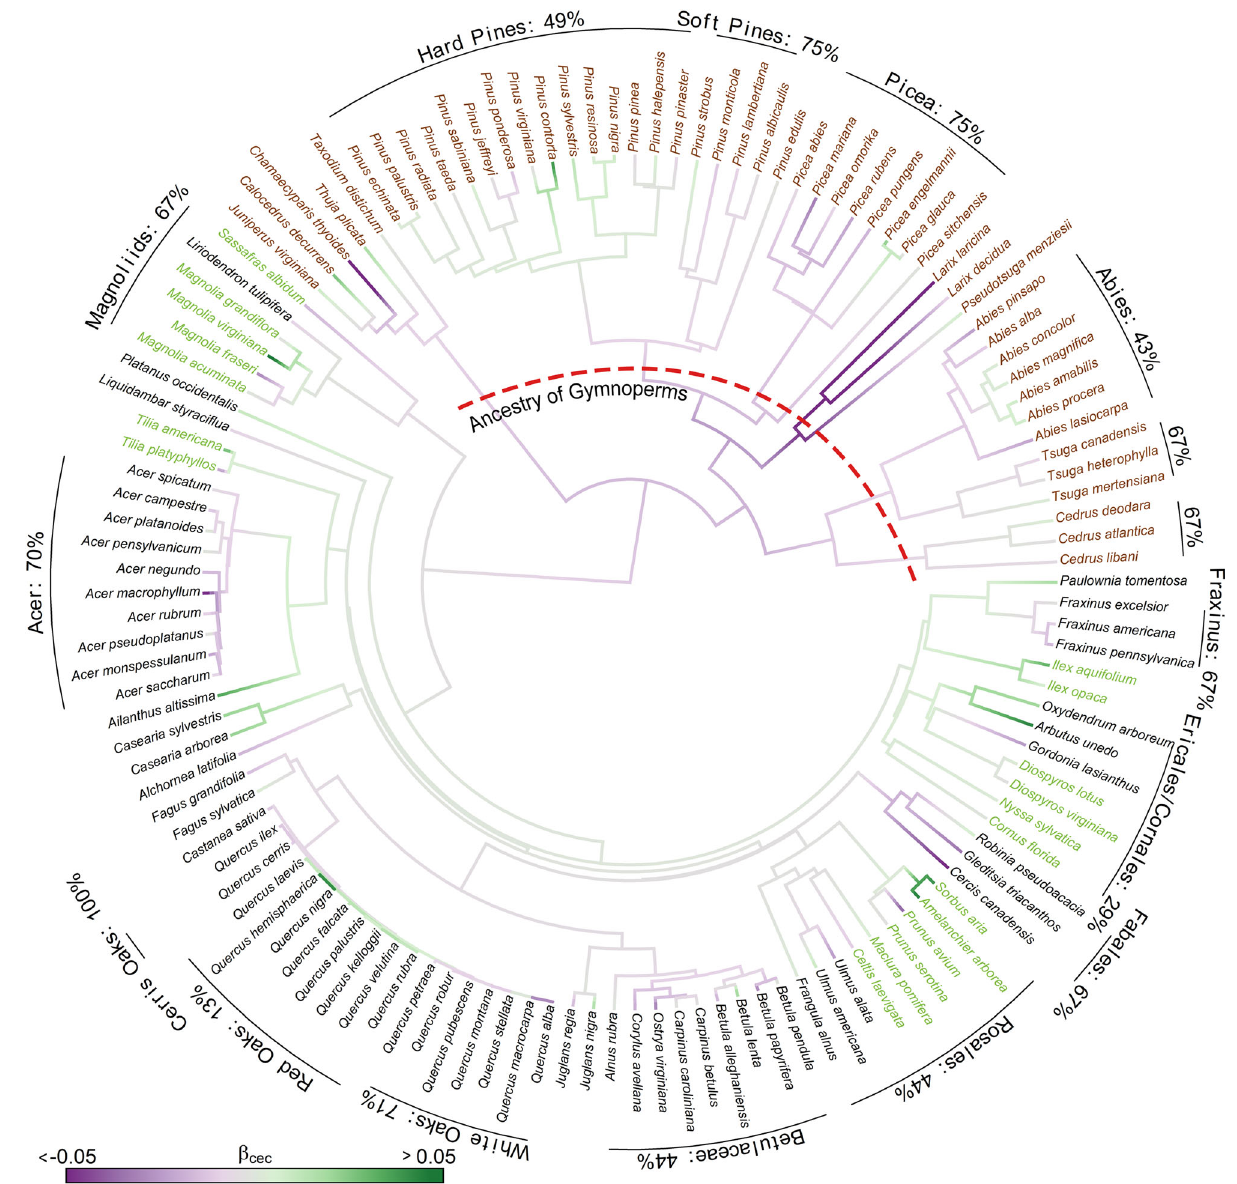
Fig. 4 Effects of soil fertility on seed production. Sensitivity of individual standardized production (ISP) to soil fertility based on within-species response to cation exchange capacity ( β cec ). Text color follows Fig. 2. Red dashed line indicates the ancestry of gymnosperms. Percentages of species that respond negatively to CEC are labeled for species groups. The analysis includes 141 species that span a suf fi cient CEC range in the Masting Inference and Forecasting (MASTIF) network to estimate a robust effect. The phylogenetic signal, estimated for 129 species (91% of species) having phylogeny data, is highly signi fi cant ( Pagel 's λ = 0.87, p < 0.001, n =